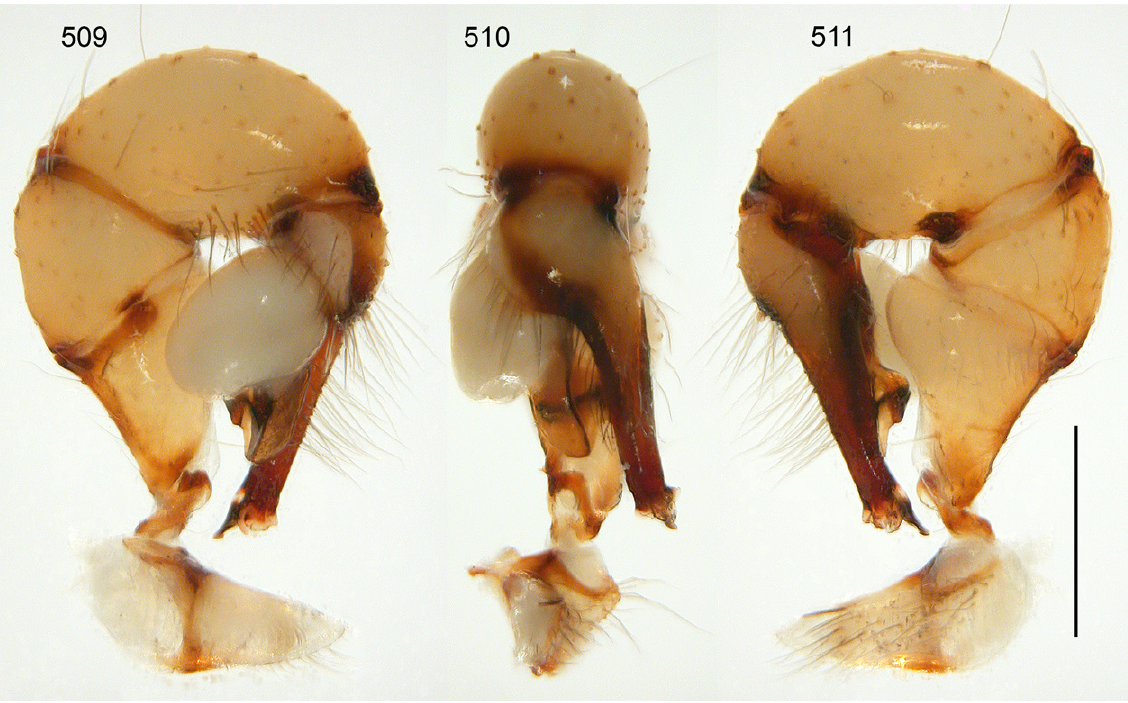
Figs 509–511. Crossopriza kittan sp. nov.; male from Oman, Ibri, Al Kittan Cave (ZFMK Ar 22424); left palp, prolateral, dorsal, and retrolateral views. Scale bar = 0.5